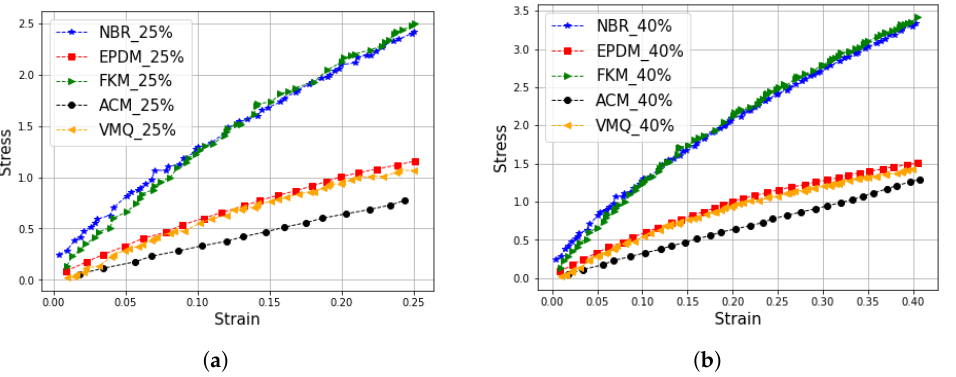
Figure 2. Stress–strain curve from short tensile testing ( a ) 25% displacement ( b ) 40% displacement.